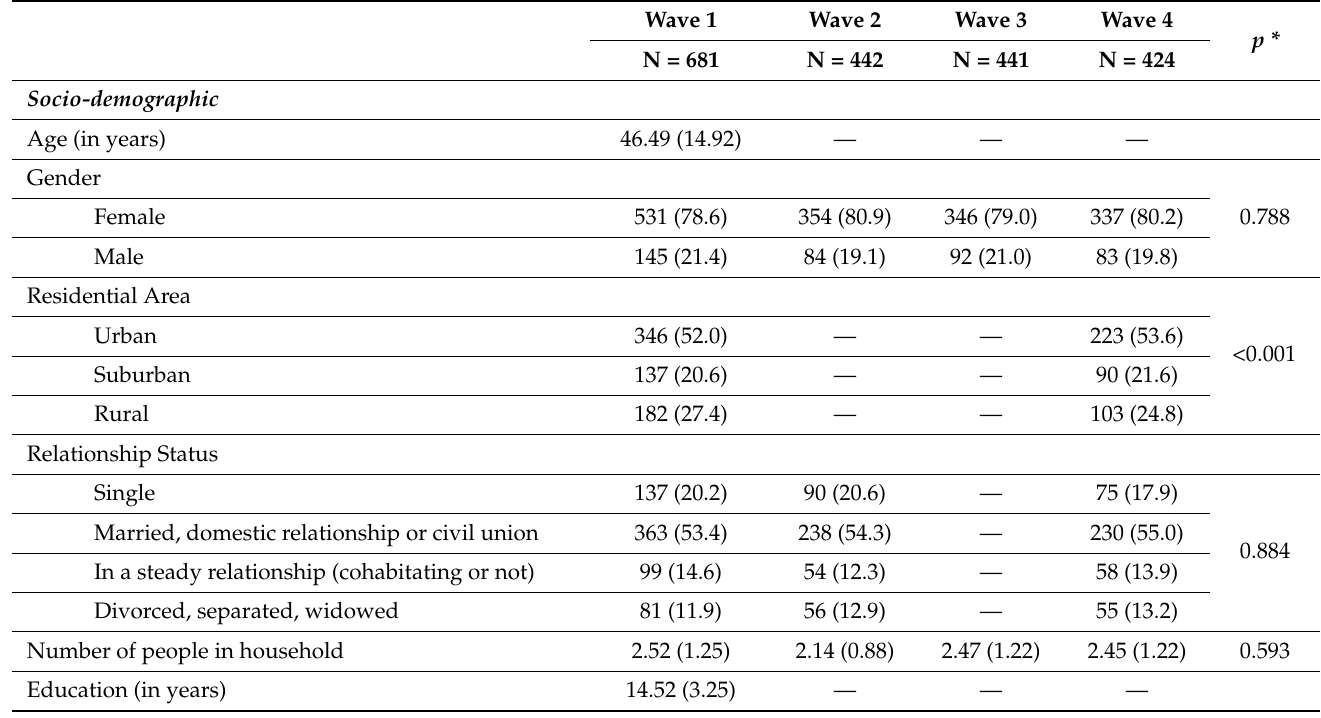
Table 1. Descriptive Statistics for French participants in the COMET